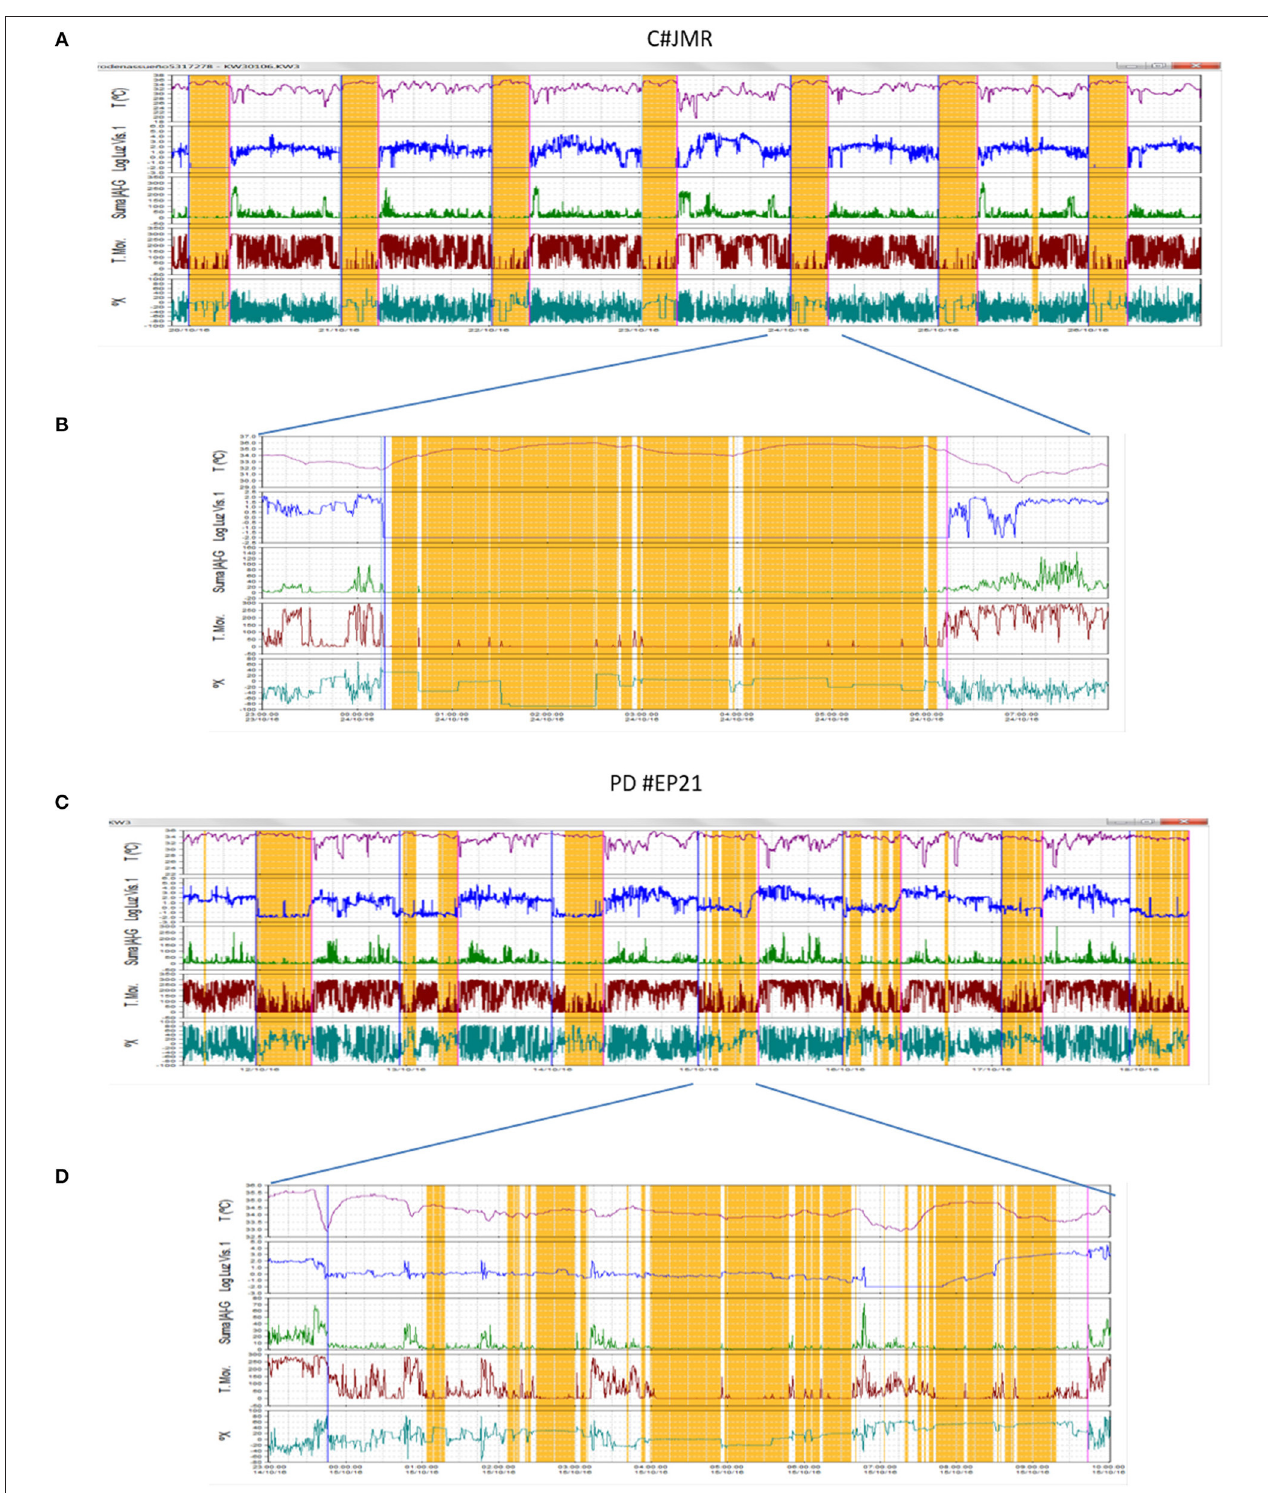
FIGURE 6 | Weekly recording (A,C) and one-night recording (B,D) via ACM of wrist temperature (red line), exposure to visible light (blue line), acceleration (green line), time in movement (brown line), wrist position (dark green line), and estimated sleep (orange bars), representative of two subjects monitored in the study: one control subject (A,B) and a patient with PD (C,D) . Surprising is the great fragmentation of sleep, accompanied by high levels of movement, frequent lights-on episodes and temperature drops of the skin during sleep that were observed in the patient with PD.